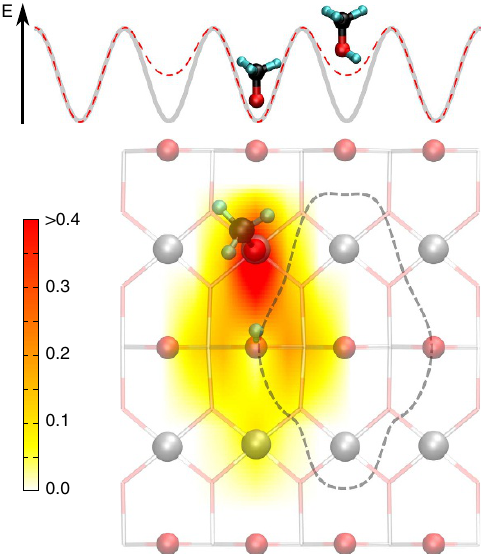
Figure 2 | Footprint of an adsorbed methanol molecule on the rutile TiO 2 (110) surface. The potential energy diagram illustrates the effect of substrate-mediated repulsion. The energy gain for a molecule adsorbing at a clean surface (grey line) is larger than for a molecule adsorbing next to an already present adsorbate (red dashed line). The amplitude of the adsorbate-induced lifting of the titania surface relaxation, which is responsible for the effective adsorbate–adsorbate repulsion, is shown colour-coded (in Å) in the lower panel.